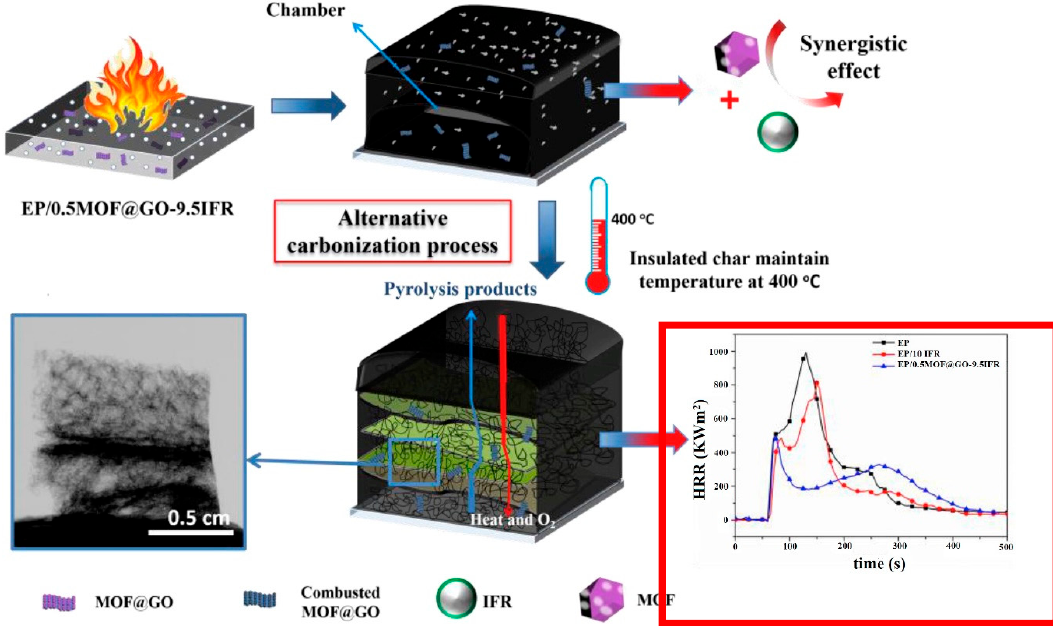
Figure 6. Fire retardancy mechanism of epoxy-containing phosphorus flame retardant loaded MOF